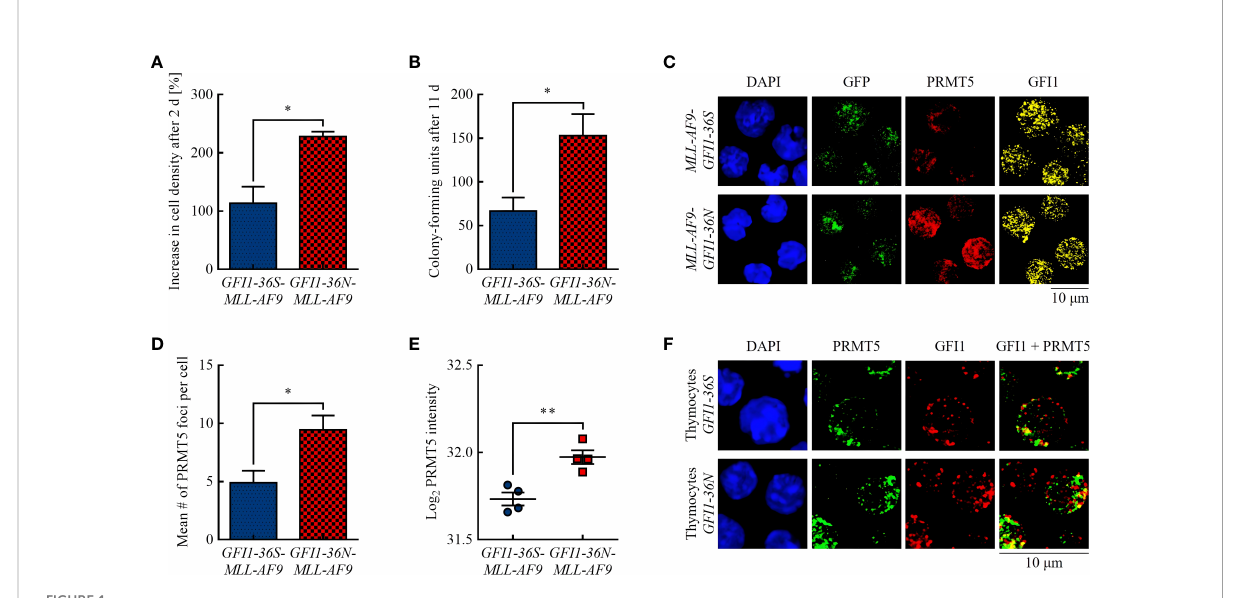
FIGURE 1 GFI1-36N leukemic cells are associated with higher proliferation and an increased protein level of the arginine-methyltransferase PRMT5. (A) Cell proliferation after 2 d. (B) CFUs after 11 d. (C) PRMT5 and GFI1 foci. Blue (DAPI) = nucleus, green (GFP) = leukemic cells, red (Cy5) = PRMT5, yellow (AF555) = GFI1. (D) Quanti fi cation of PRMT5 foci. (E) PRMT5 protein intensity detected by MS-based proteomics. (F) PRMT5-GFI1 colocalization in non-leukemic thymocytes. Blue (DAPI) = nucleus, green (AF488) = PRMT5, red (AF555) = GFI1. Mean ± SEM ( n = 3 – 4); p * ≤ 0.05, p ** ≤